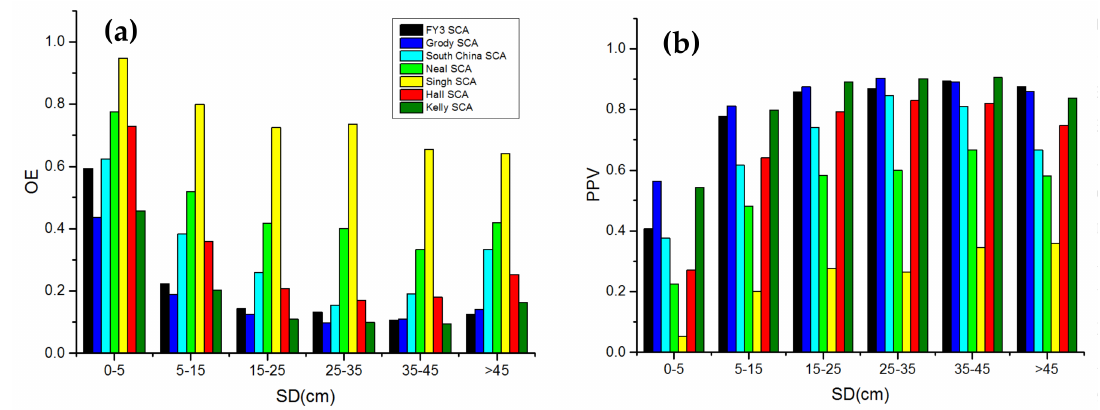
Figure 8. OE ( a ) and PPV ( b ) of the seven PMW SCA maps compared to ground observations at different snow